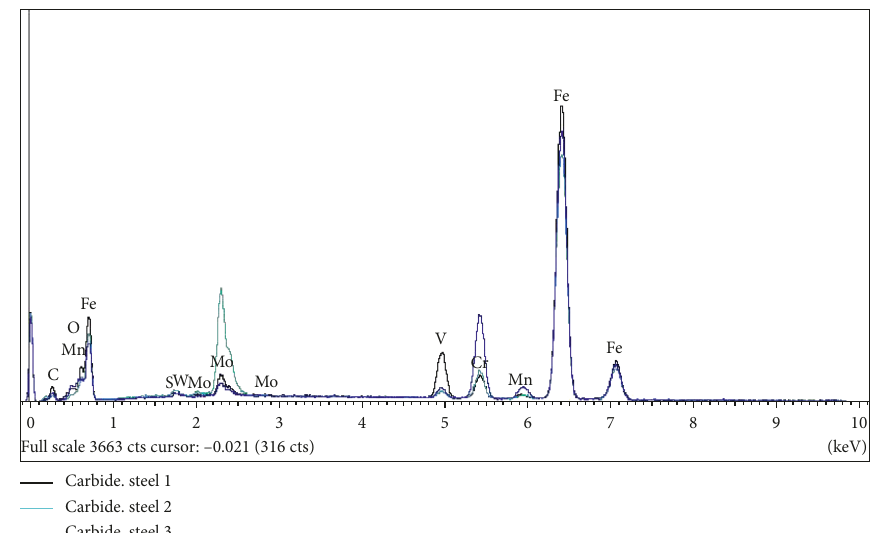
Figure 20: Comparison of the carbides’ nature of the tool steels studied.